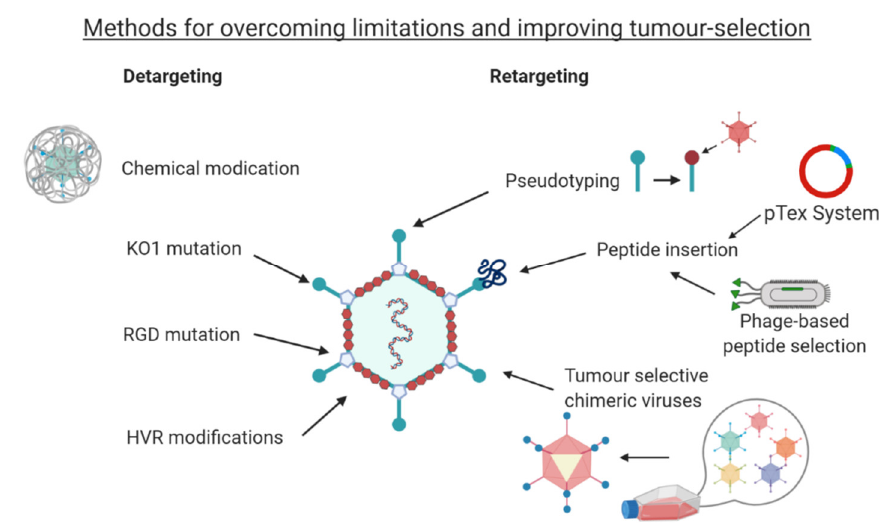
Figure 8. Overview of putative adenoviral detargeting and retargeting approaches. Created with https: // BioRender.com.